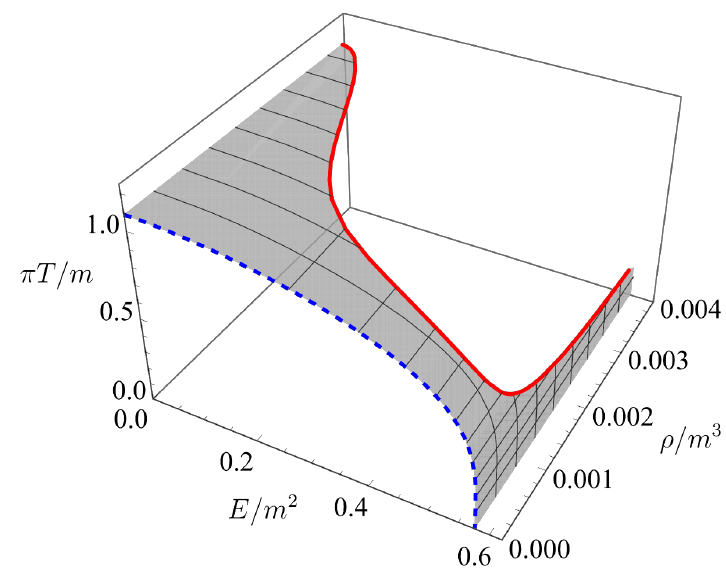
Figure 2 . The three-dimensional phase diagram for the nonequilibrium phase transition. The red solid curve denotes the second-order phase transition points. The blue dashed curve denotes the first-order phase transition points at ρ = 0 . The gray surface between them denotes the first-order phase transition